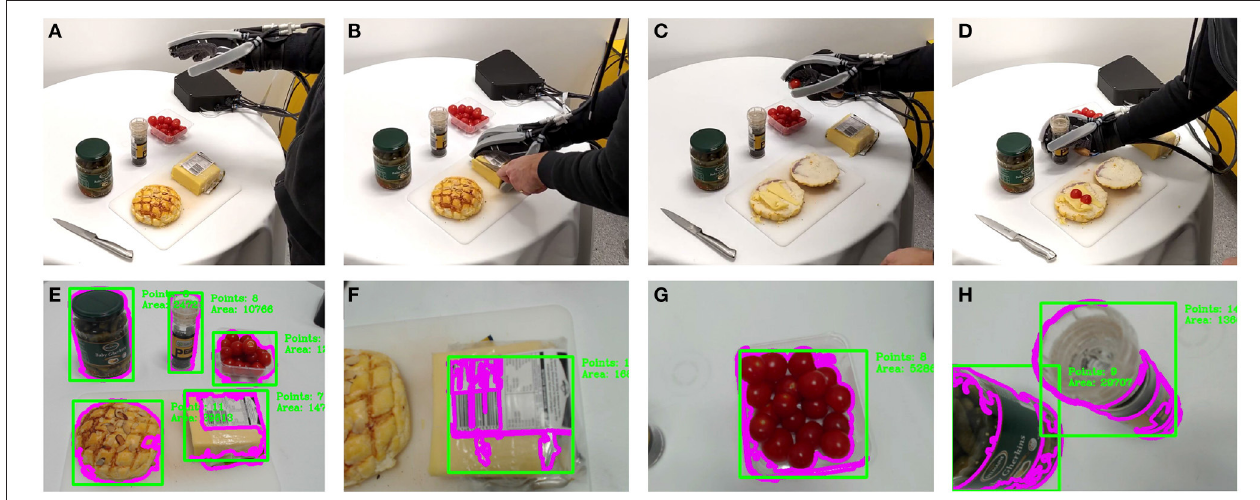
FIGURE 6 | Instances from the execution of the exoskeleton glove control enhancement experiment. The top row shows the robotic exoskeleton glove executing the experiment. The bottom row shows the camera field of view (E) with the detected objects. (A) Presents the user capturing a scene image that is segmented and submitted for labeling to the framework. (B–D) Present the user grasping examples of medium (cheese), soft (tomato), and hard (pepper) objects. (F–H) Present the camera view during reach to grasp motions for the cheese, tomato, and pepper objects, respectively.